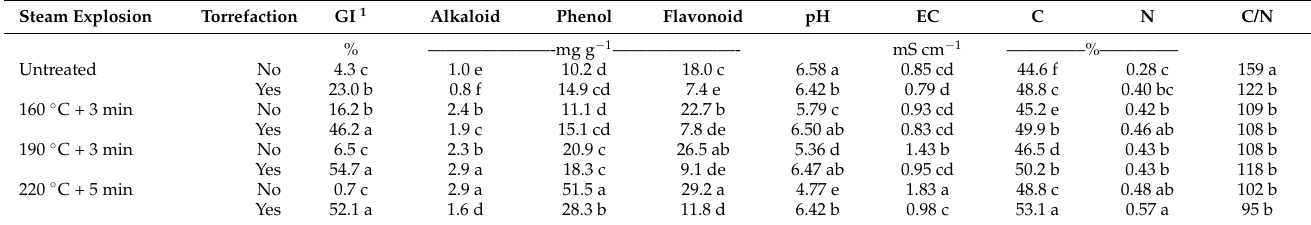
Table 4. Germination index (GI), concentration of total alkaloid, phenol, and flavonoid, pH, elec- trical conductivity (EC), total carbon (C), total nitrogen (N), and C/N ratio as affected by steam explosion × torrefaction